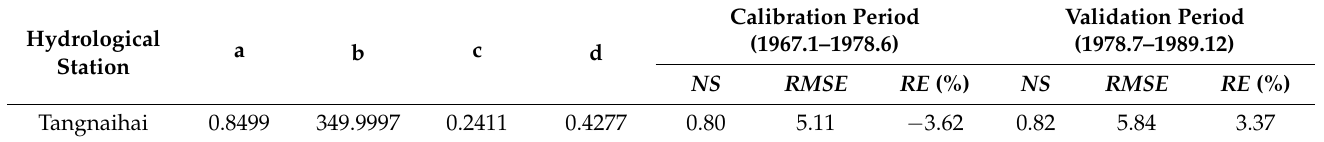
Table 2. Monthly runoff simulation results in the pre-change period using the monthly ABCD model. Hydrological Station